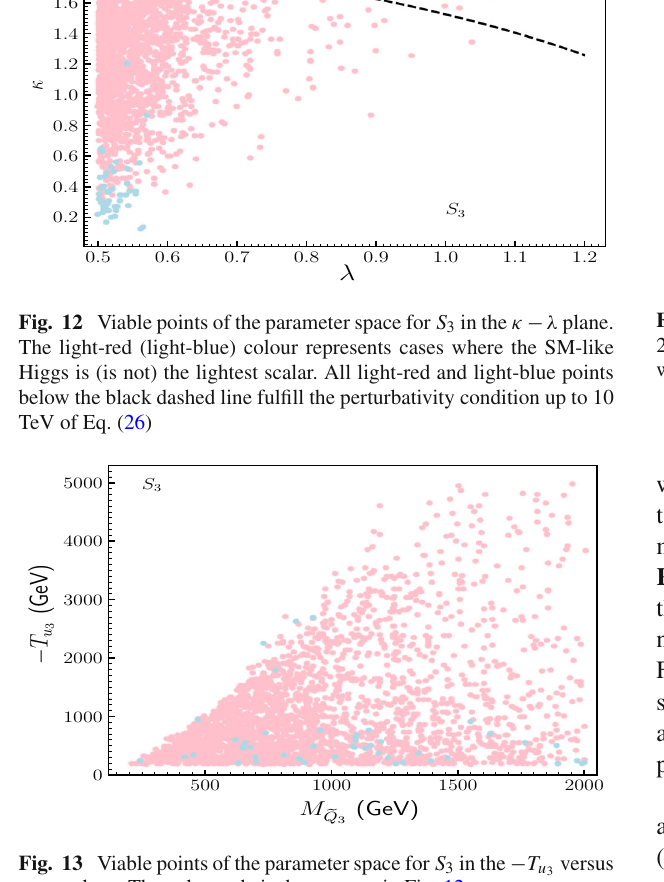
Fig. 14 The singlet component (cid:8) | Z H | 2 of the singlet-like i h (cid:6) ν R iR scalars h versus their masses, for S 3 . We only show here viable points with scalar masses smaller than 1000 GeV. In the lower part we zoom in the low-mass region